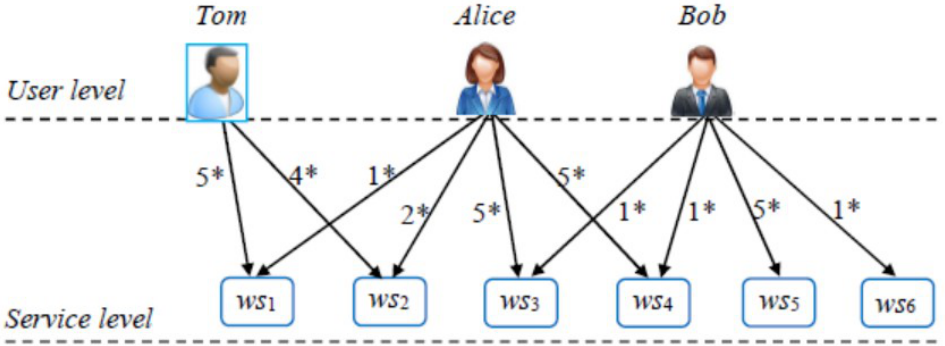
Figure 1. A recommendation failure example (see our previous work [12]).